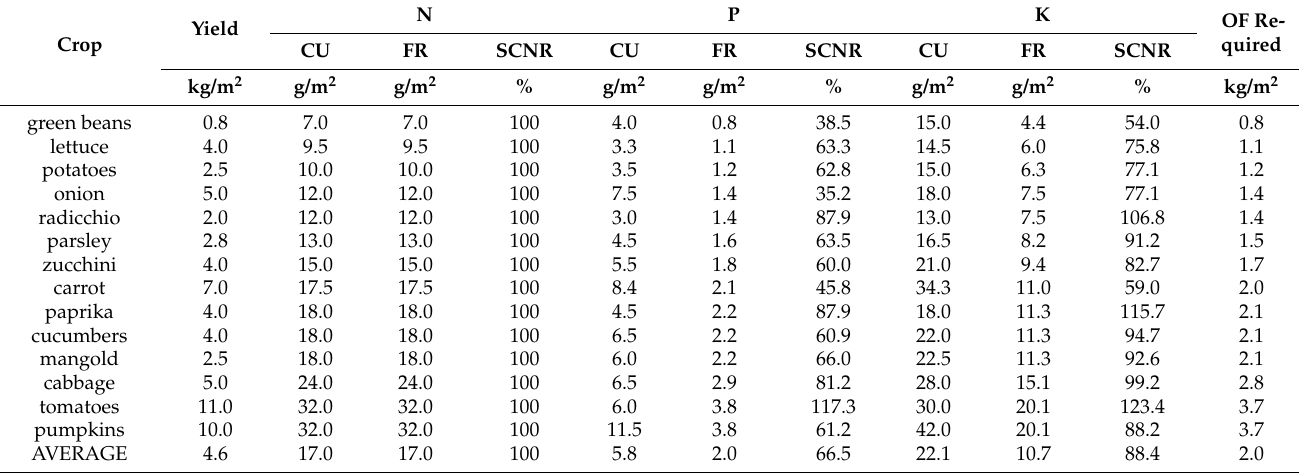
Table 9. Required application of organic fertilizer (OF) from F. japonica (1.59% N, 0.19% P, 1% K; crop recovery efficiency for N 46%) for selected crops in non-marketable urban gardening in Ljubljana, Slovenia.